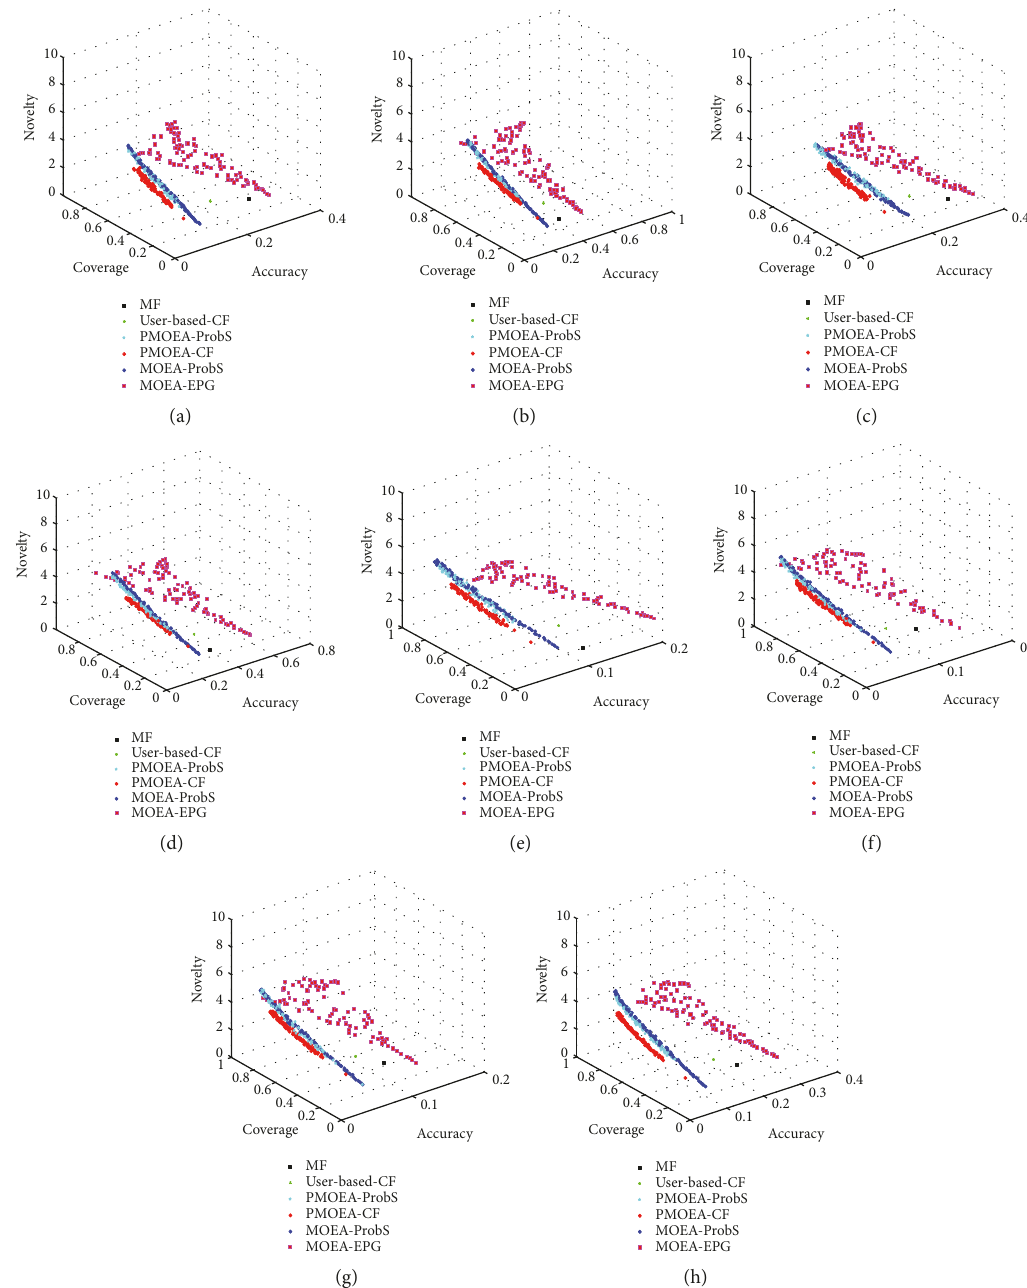
Figure 10: Final recommendation results of comparison algorithms under the accuracy-coverage-novelty space for (a) Movielens 1, (b) Movielens 2, (c) Movielens 3, (d) Movielens 4, (e) Netflix 1, (f) Netflix 2, (g) Netflix 3, and (h) Netflix